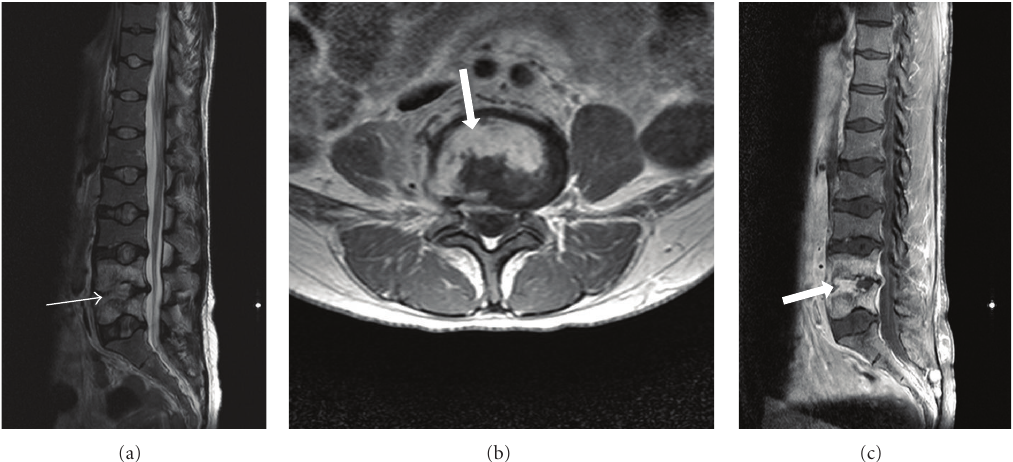
Figure 5: (a), (b), and (c) T2W sagittal, T1W axial and sagittal postgadolinium images in a patient with sickle cell anaemia, showing high signal in the anterior aspect of the L4/5 disc on T2W sequence (thin arrow) and enhancement on the post contrast images (thick arrows) consistent with discitis.